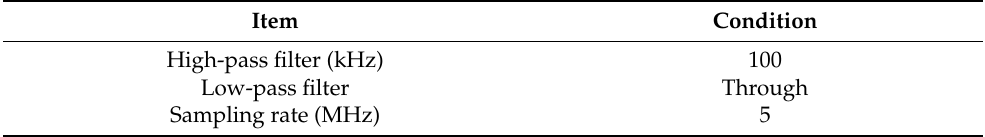
Table 7. AE measurement conditions.